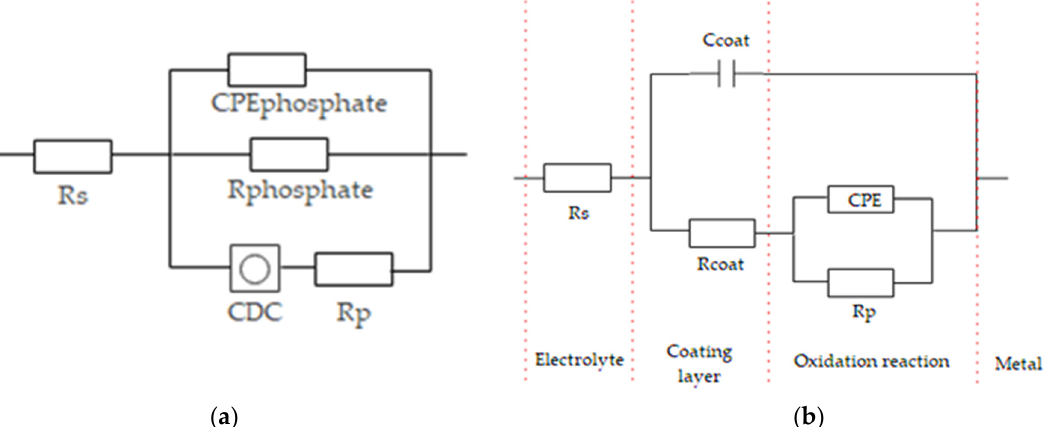
Figure 5. Equivalent electric circuit for fitting EIS parameters for ( a ) phosphate steel surface modified with Ni 2+ , Ce 3+ , and Ti 2+ ions and ( b ) samples with three types of coating [37].